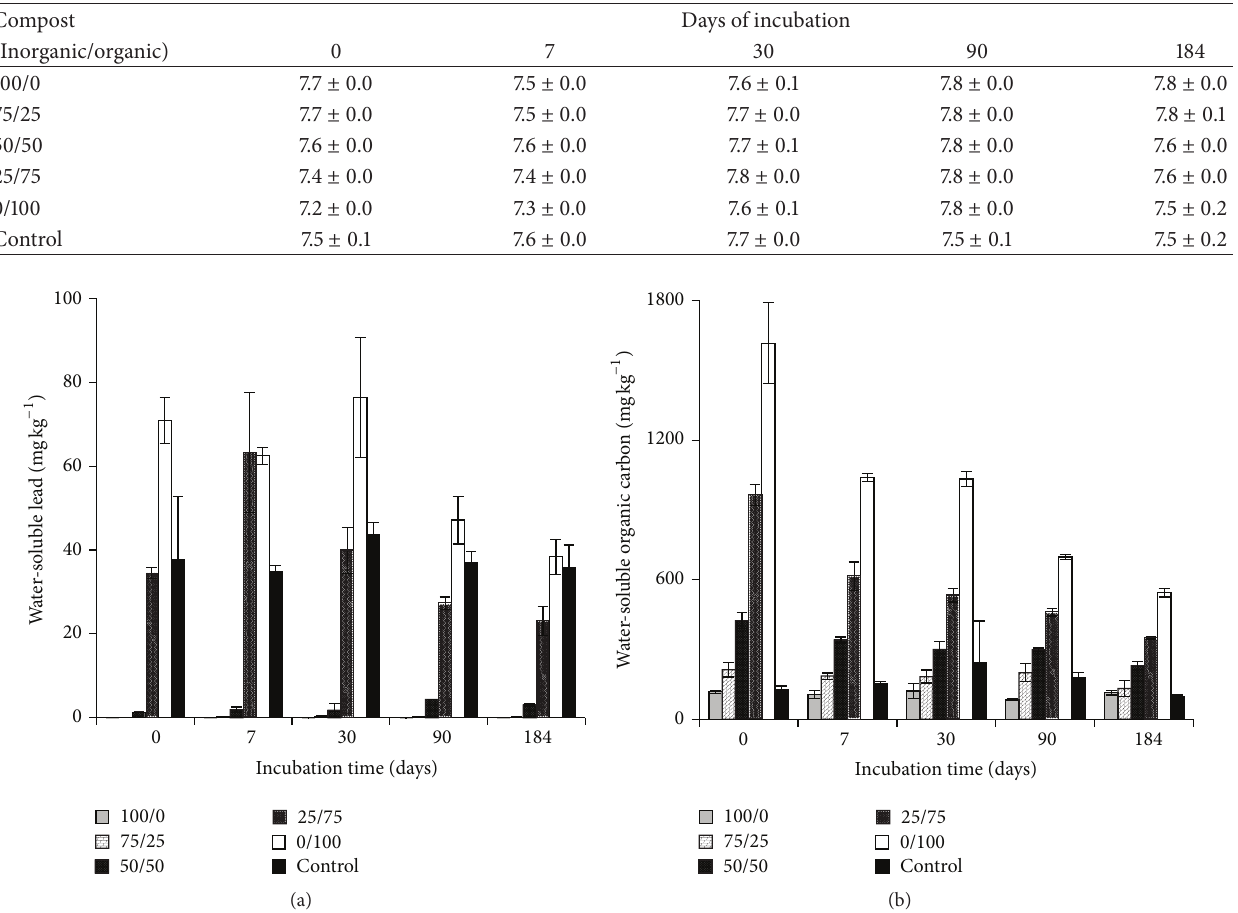
Figure 1: Water-soluble lead (a) and organic carbon (b) in soil amended with AMC of inorganic/organic = 100/0, 75/25, 50/50, 25/75, and 0/100 and without AMC (control). Vertical bars indicate the standard